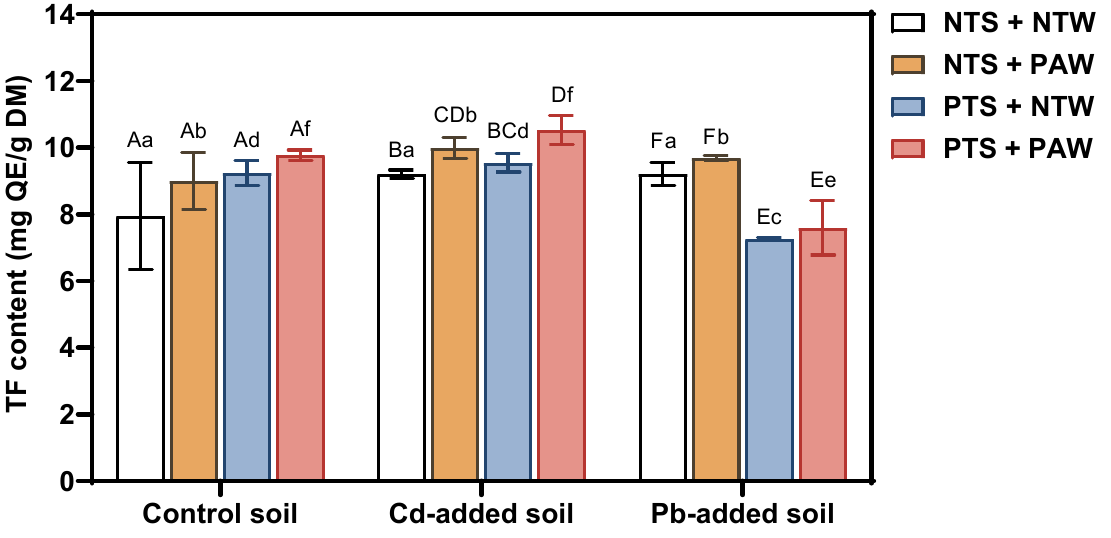
Figure 5. Comparison of TF content in water spinach with different plasma treatments grown in different soil. NTS: non-treated seed; NTW: non-treated water; PAW: plasma-activated water; PTS: PAW-treated seed. Different uppercase letters indicate the significant difference between plasma treatment, while different lowercase letters indicate the significant difference between cultivation soil.